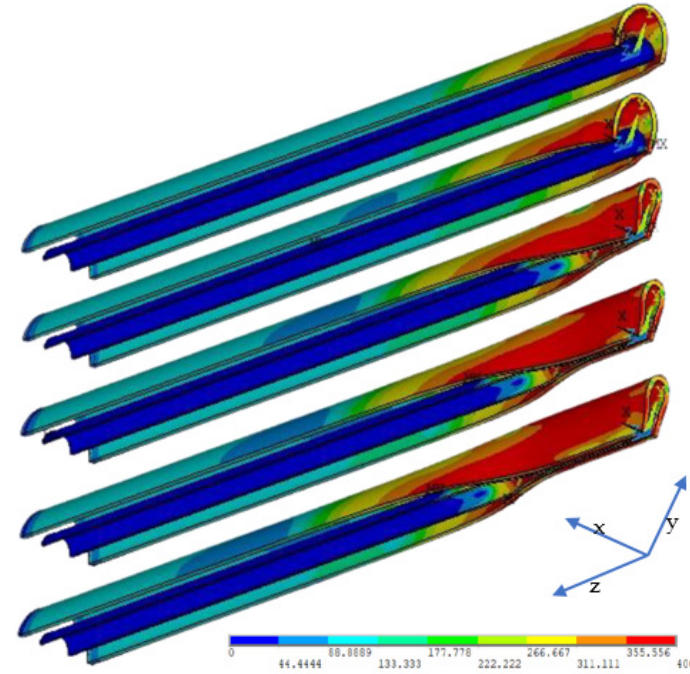
Figure 6. Distribution of von Mises stress during buckle propagation of Case N40 (unit: MPa).